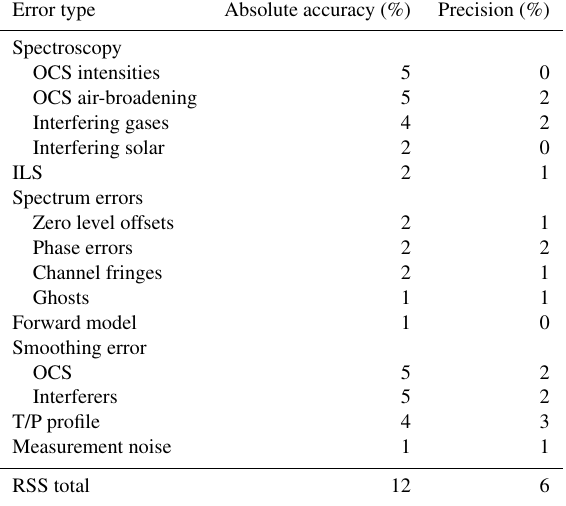
Table 4. Error budget of retrieved ground-based OCS amounts. The precision is the likely difference between observations made under nominally identical conditions. It is smaller than the absolute accu- racy due to the absence of stationary errors, which are the same or similar in every